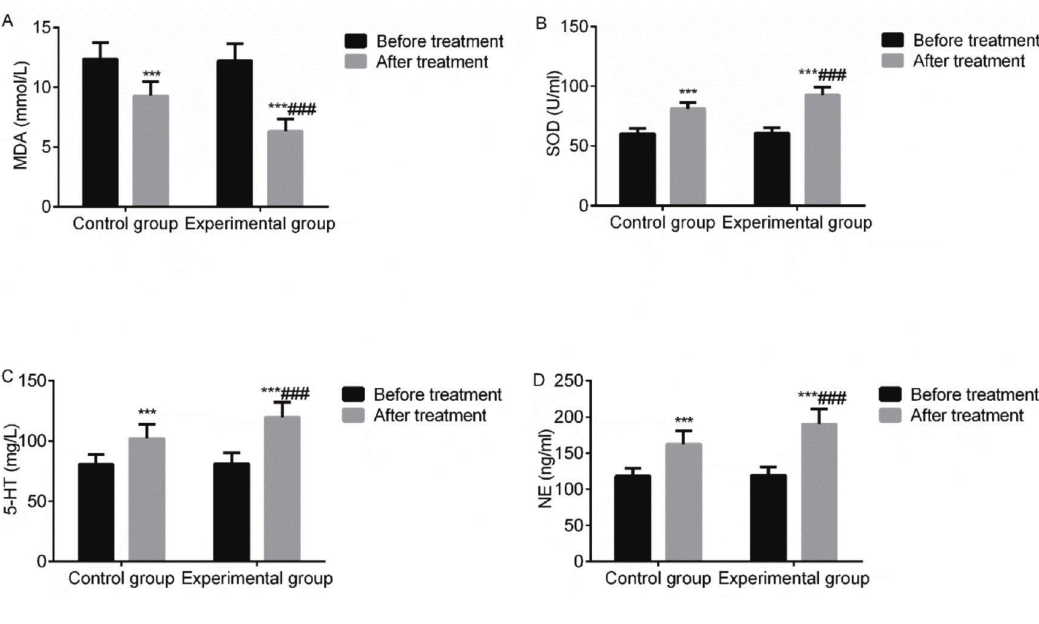
Figure 3 - Comparison of the changes in serum indices between the two groups before and after treatment. Note: compared with the group before treatment, *** p o 0.001; compared with the control group, ### p o 0.001.